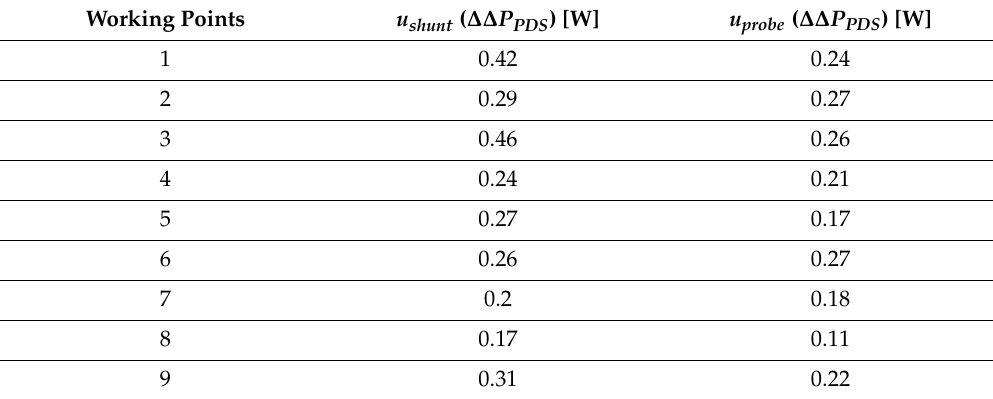
Table 13. ∆∆ P PDS uncertainty for each working condition and for case